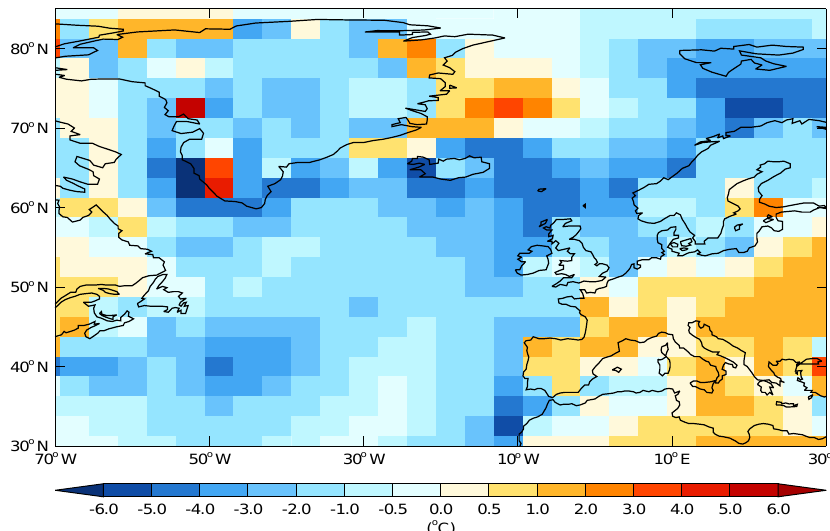
Figure 7. Simulated summer (July, August, and September) near-surface air temperature anomaly compared with pre-industrial values at 130ka over southern Europe and the North Atlantic region. The simulation is forced with 0.2Sv of freshwater flux as well as changes to the GHGs and orbital forcing